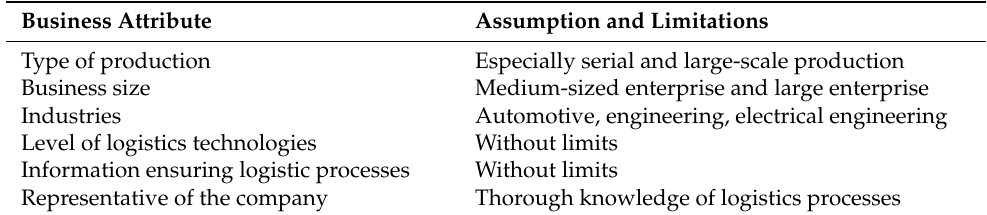
Table 6. Assumptions and limitations of the methodology for its practical